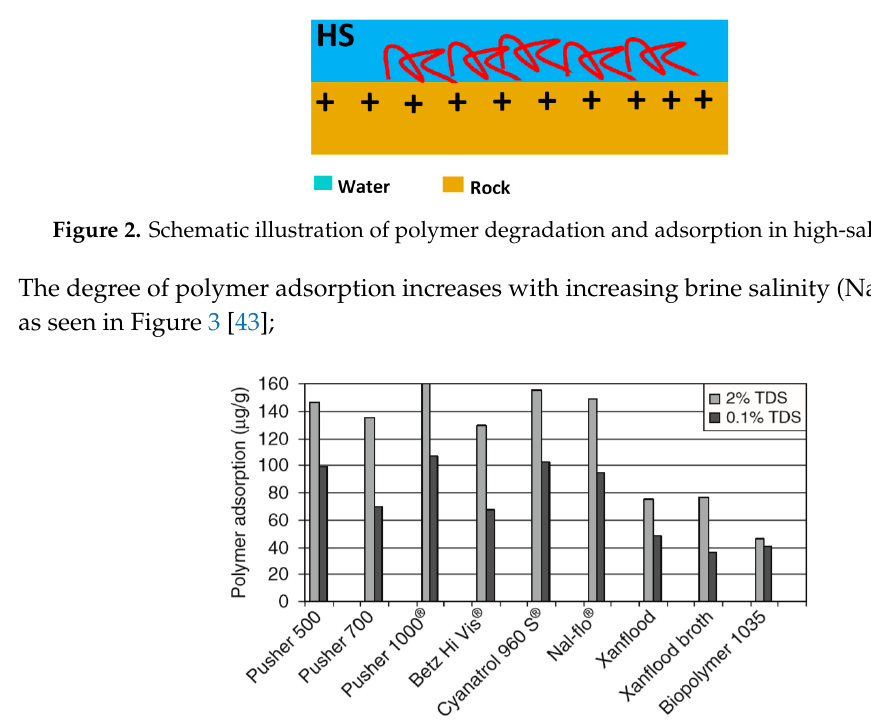
Figure 3. Effects of salinity on the adsorption of different polymers [43]. TDS: Total dissolved solids.